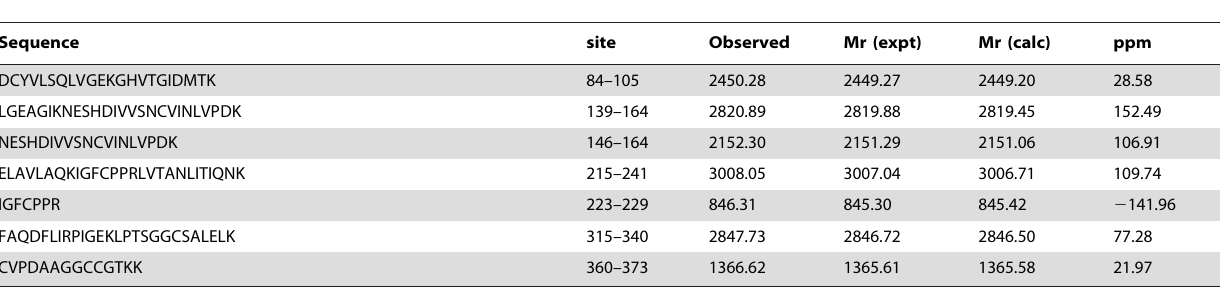
Table 1. Sequences for the peptide fragments of hAS3MT analyzed by MALDI-TOF-MS.